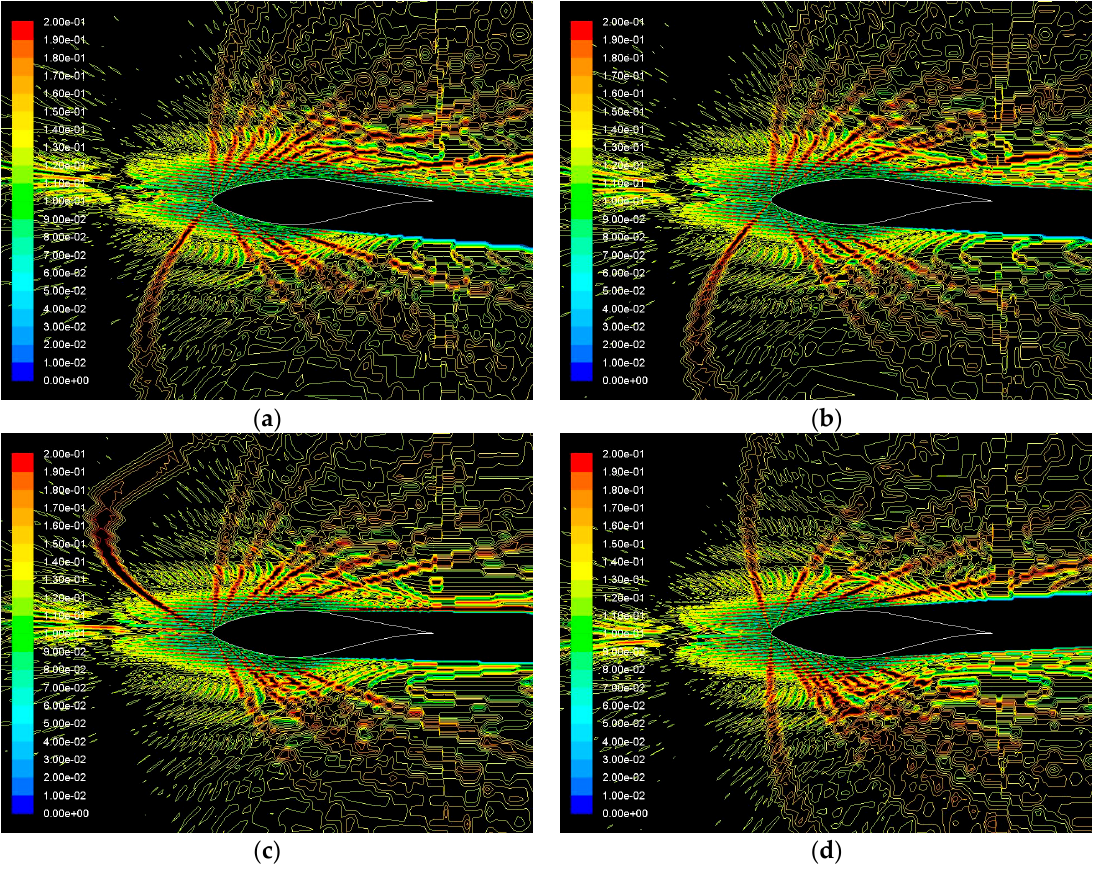
Figure 16. Contours of DPM concentration at ( a ) − 3°; ( b ) 0°; ( c ) 3°; and ( d ) 9° angles of attack at Re = 2 × 10 6 with the realizable k– ε turbulence model for an S809 airfoil for air-sand particle two-phase flow and 10% concentration of sand particles in the air.